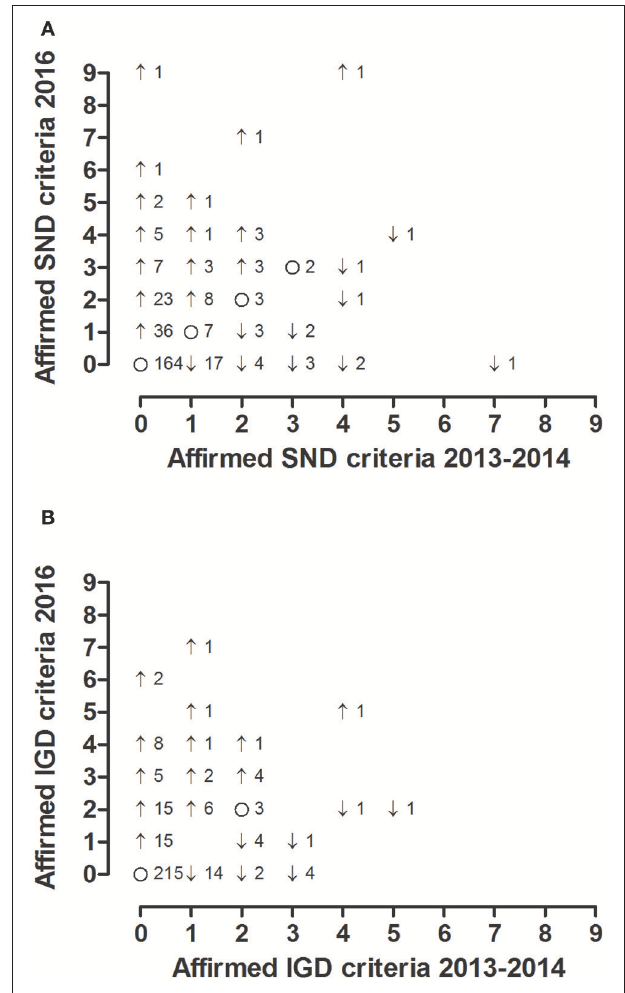
FIGURE 2 | The graphs plot the number of affirmed SND (A) and IGD (B) criteria quantified during the first survey conducted in 2013 and 2014 (x-axis) and during the second survey conducted in 2016 (y-axis). The figures next to the dots represent the number of underlying individuals. ↑ increase, ↓ decrease, and o no change of affirmed criteria during the follow-up. SND social network use disorder, IGD internet gaming